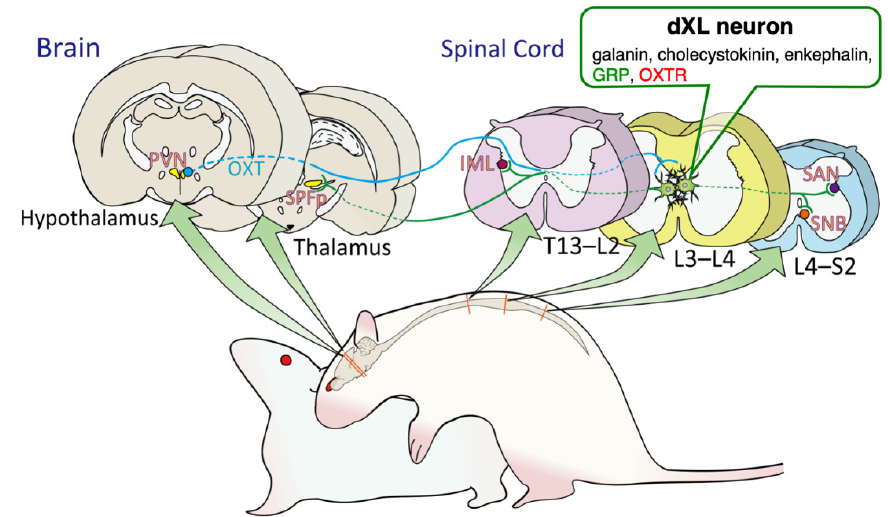
Figure 6. Schematic illustrations of the brain–spinal neural circuits that control male sexual activity in rats. Neurons located in the dorsal lamina X of the lumbar spinal cord (dXL) express galanin, cholecystokinin, enkephalin, gastrin-releasing peptide (GRP), and oxytocin receptor (OXTR). dXL neurons can also be identified as lumbar spinothalamic (LSt) neurons projecting from the lumbar spinal cord to the thalamus. In addition, dXL neurons project to both parasympathetic (sacral autonomic nucleus [SAN]) and sympathetic (intermediolateral cell column [IML]) systems in the thoracic spinal cord (the T13–L2 level) preganglionic neurons and sexual motor neurons (the spinal nucleus of the bulbocavernosus, SNB) located in the lower lumbar and upper sacral spinal cord (the L4–S2 level). In the thalamus, the parvocellular portion of the subparafascicular thalamic nucleus (SPFp) may receive sexual information from the afferent inputs of spinal dXL